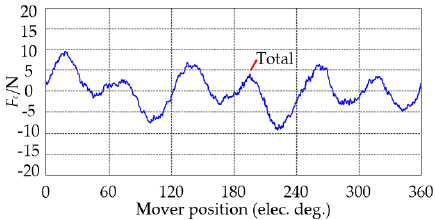
Figure 18. The measured waveform of the total detent force.